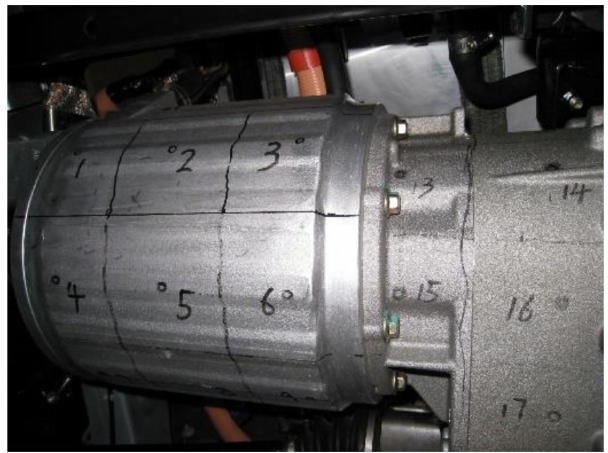
Figure 4. Mesh division of the electric drive